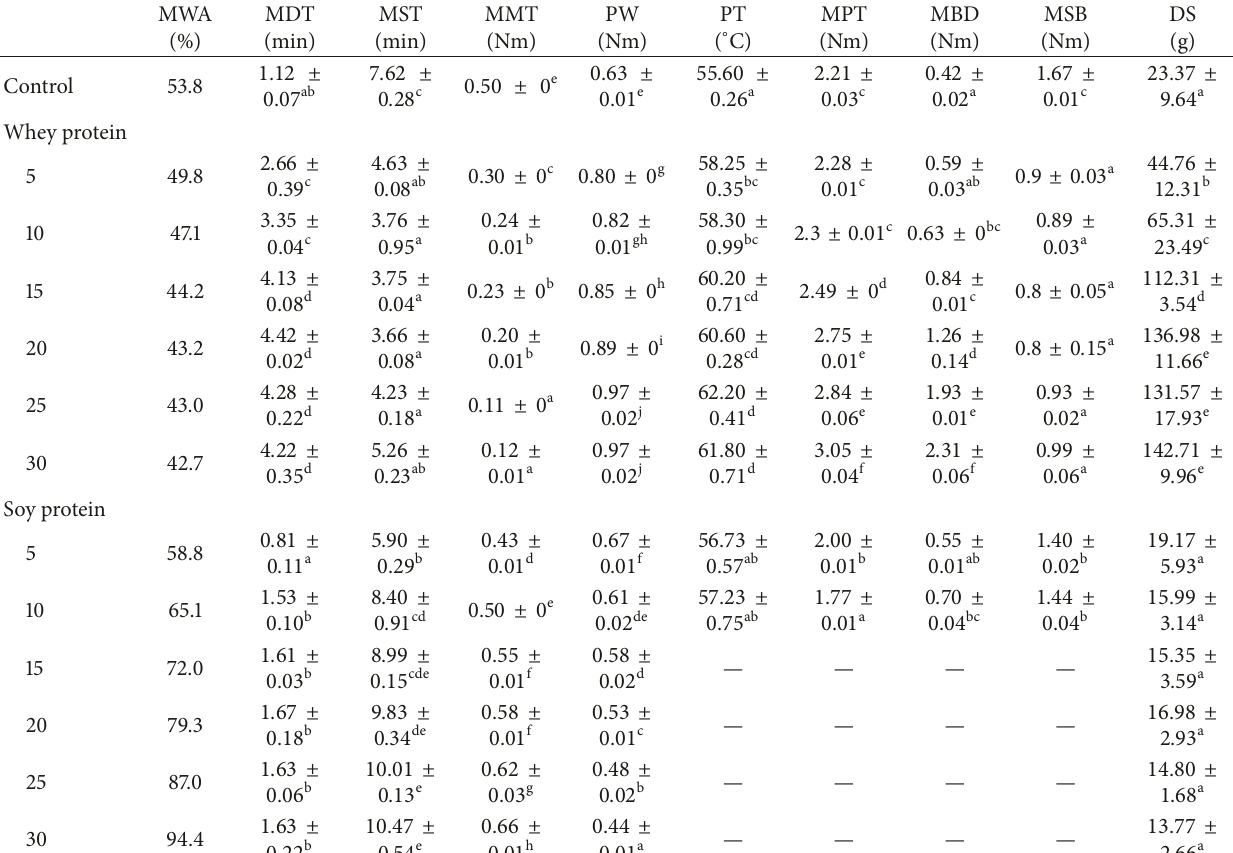
Table 1: Effect of whey and soy protein addition on thermomechanical properties and stickiness of wheat dough a